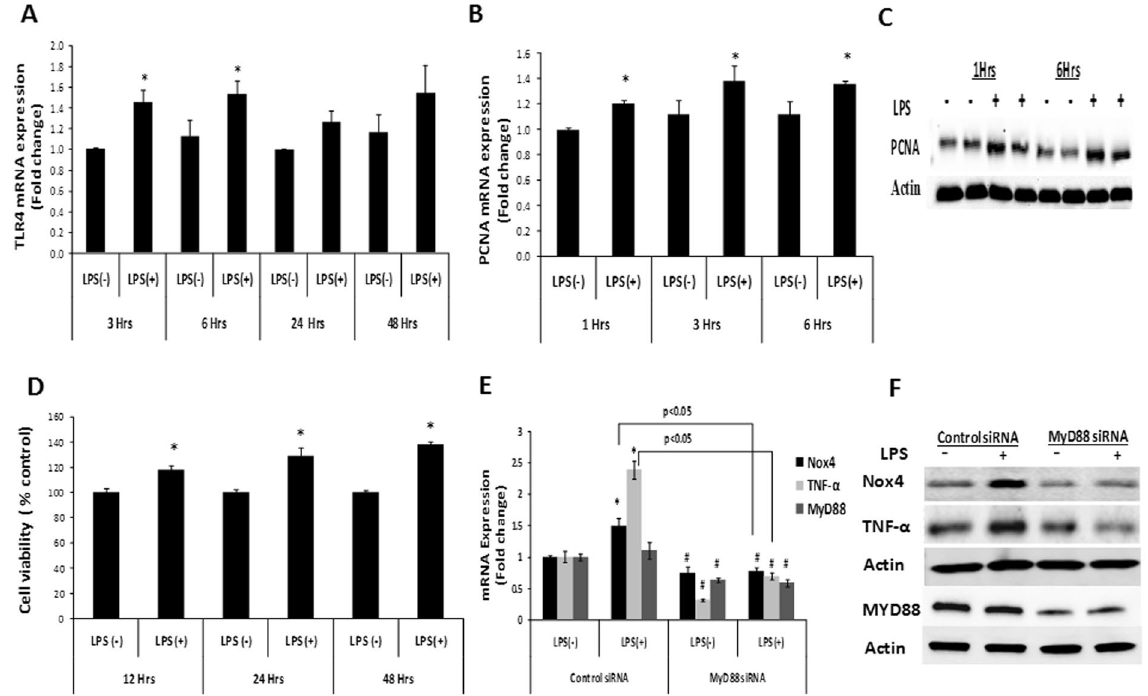
Figure 2. LPS increased PCNA expression and LPS-TLR4 signaling in hepatoma cells is MyD88 dependent. Huh7 cells were either treated with LPS or PBS for indicated time points and analyzed for TLR4 ( A ) and PCNA ( B ) mRNA expression by qRT-PCR. ( C ) PCNA protein levels were measured by western blotting in Huh7 cells treated either LPS or PBS at indicated time points. Actin was used as a control for protein loading. ( D ) Huh7 cells were either treated with LPS or PBS for indicated time points and viable cells were measured by cell proliferation assay. ( E ) Huh7 cells were transfected with control or MyD88 siRNA for 48 hrs, and treated either with LPS or PBS for an additional 3 hrs. Then, samples were analyzed for Nox4, TNF- α and MyD88 mRNA levels by qRT-PCR. ( F ) Nox4, TNF- α and MyD88 protein levels were measured by western blotting and actin was used as a loading control. # indicates statistically significant difference from control siRNA LPS ( − ) (p < 0.05). * indicates statistically significant difference from the corresponding controls (p < 0.05). Lines with p values also indicate statistically significance (p < 0.05) between the